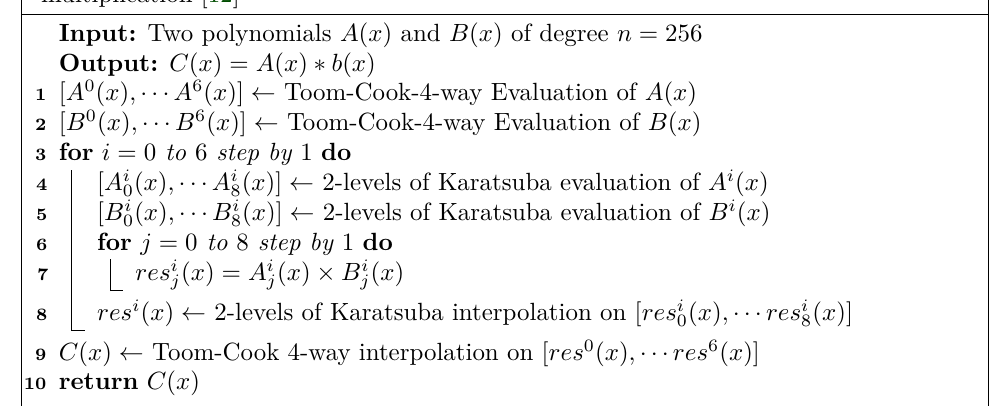
Algorithm 4: Pseudocode for Toom-Cook-4-way + Karatsuba + schoolbook multiplication